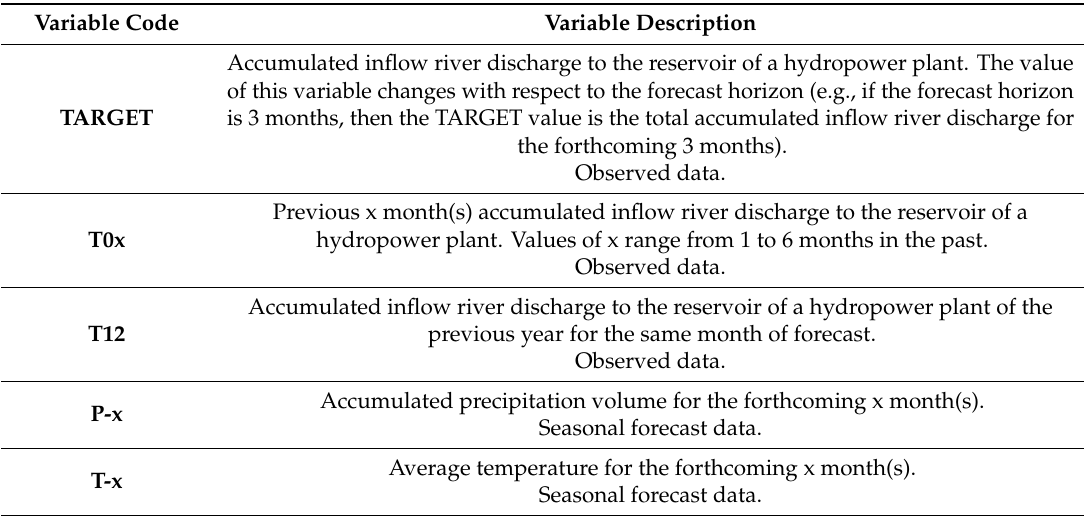
Table 2. Variable codes and related description of the data used for calibrating statistical methods and training the machine learning algorithms within